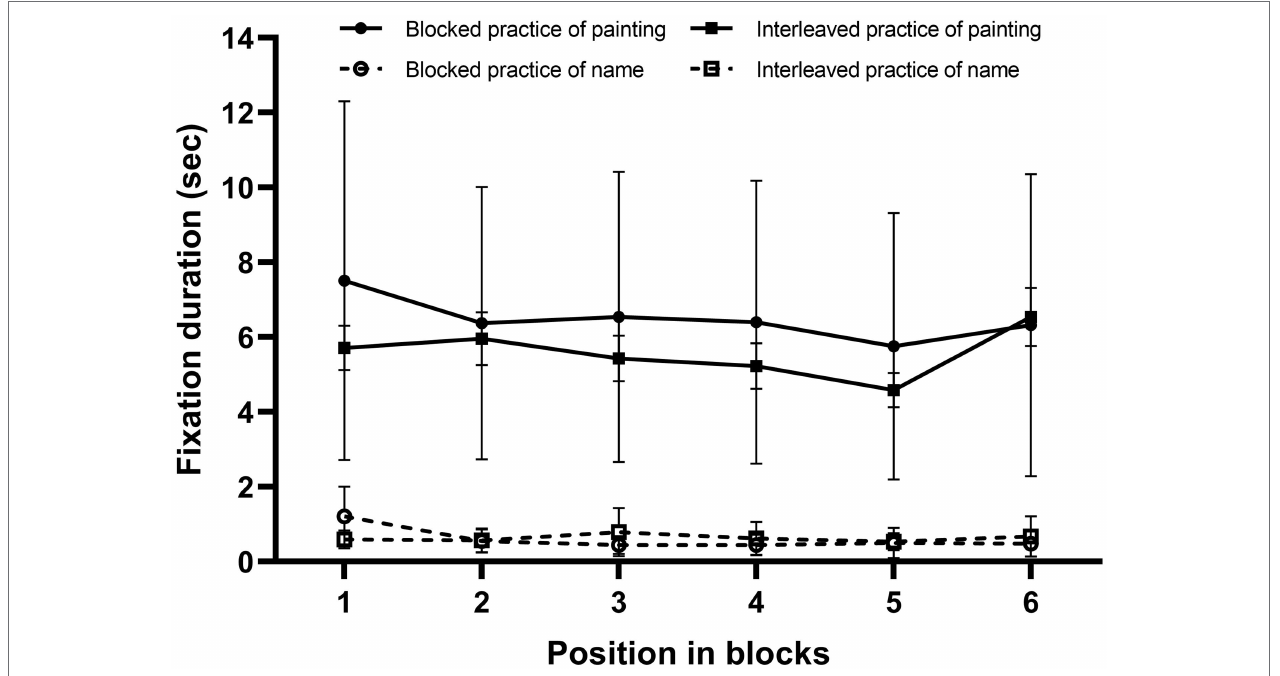
FIGURE 5 | Mean fixation durations for painting and name, as a function of relative position and study condition, in Experiment 2. Error bars represent